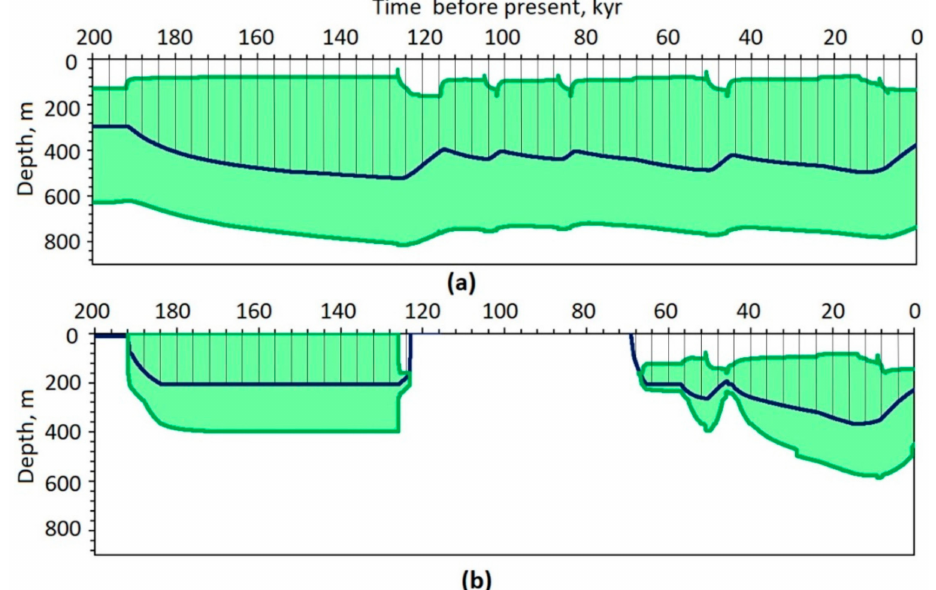
Figure 9. Permafrost and GHSZ evolution under the extraglacial ( a ) and glacial conditions ( b ) on 40 m